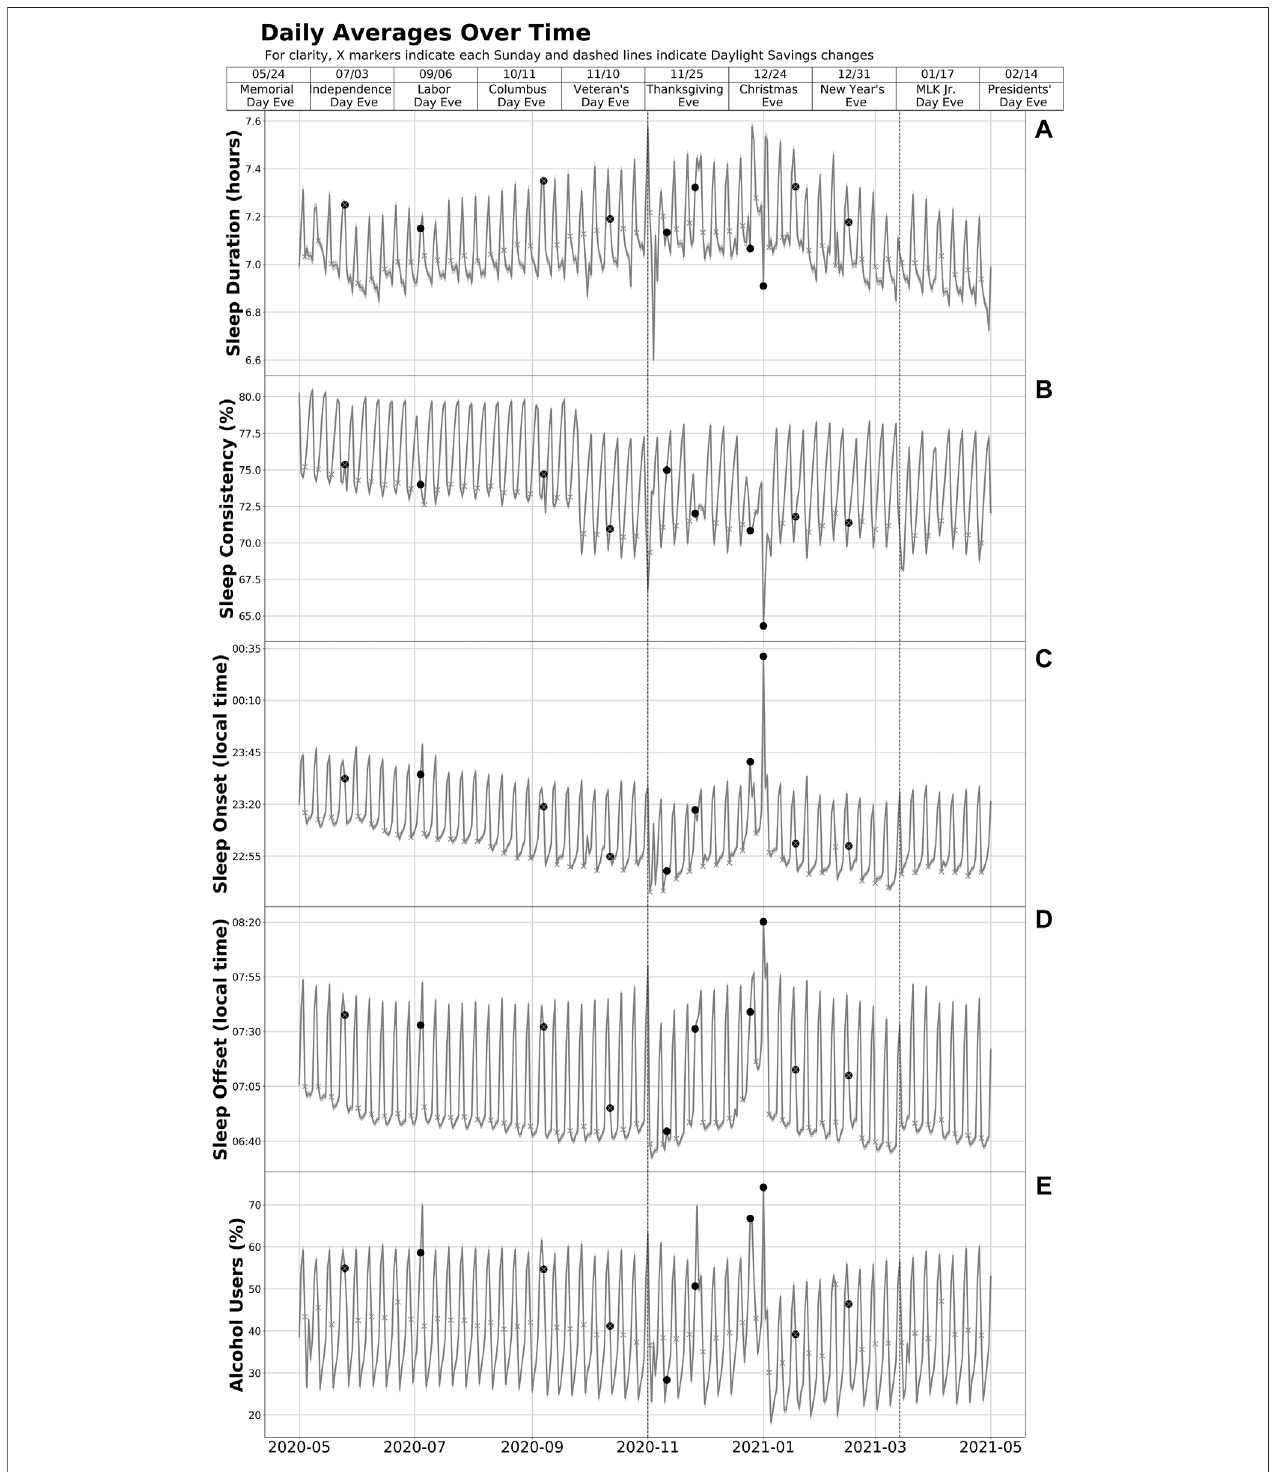
FIGURE 1 | Sleep duration (A) , consistency (B) , timing (C, D) , and alcohol use (E) among US Adult WHOOP Users During 1 May 2020 — 1 May 2021. Data were collected on participants ’ sleep duration, sleep consistency, sleep timing, and alcohol use from 1 May 2020 through 1 May 2021. This fi gure shows the daily sample means and 95%con fi dence intervals over the study interval for sleep duration, consistency, and timing based on data from the 10,350,760 sleep episodes recorded by the 24,250 participants in the primary analytic sample. The measure for alcohol is the percentage of users who responded af fi rmatively to having used alcohol in daily surveys among the 13,904 participants in the subsample with data on alcohol use. Each round scatter point represents the eve of a US public holiday or DST transition and indicates a nocturnal sleep episode that ended the following day. For example, the point on 31/12/20 (New Year ’ s Eve) represents the nocturnal sleep episode that took place from the evening of 31 December 2020 (or the early morning hours of 1 January 2021) through the morning of 1 January 2021.